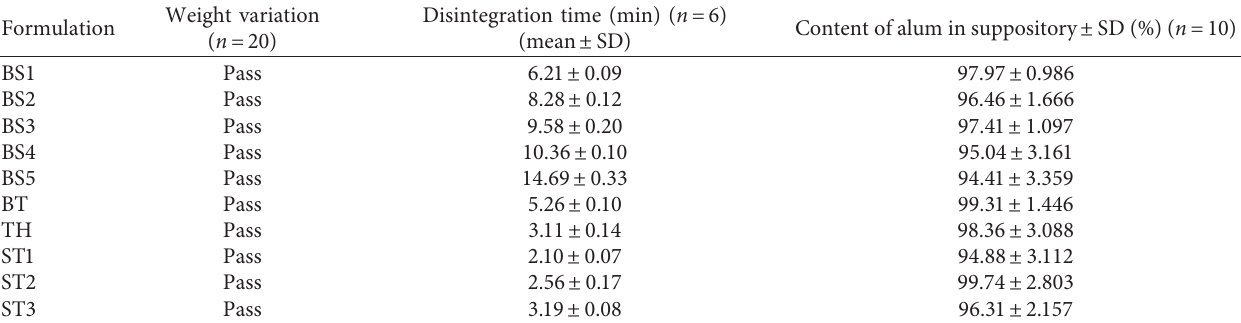
Figure 6: FT-IR spectra of (a) alum, (b) beeswax +shea butter+alum (1:1 :1), and (c) beeswax+shea butter (1:1). Table 4: Quality control evaluation of various suppository